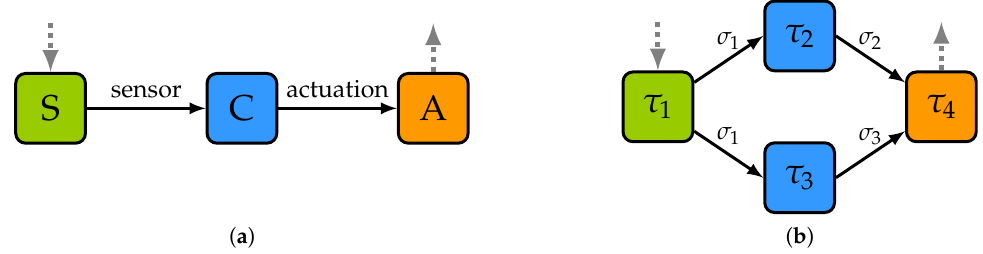
Figure 2. Example of applications. ( a ) Control application example. ( b ) Generic application